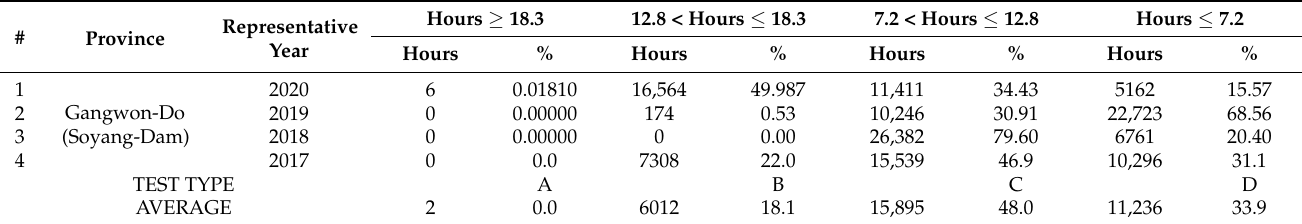
Table 6. Water temperature data for average weighting in the Republic of Korea.